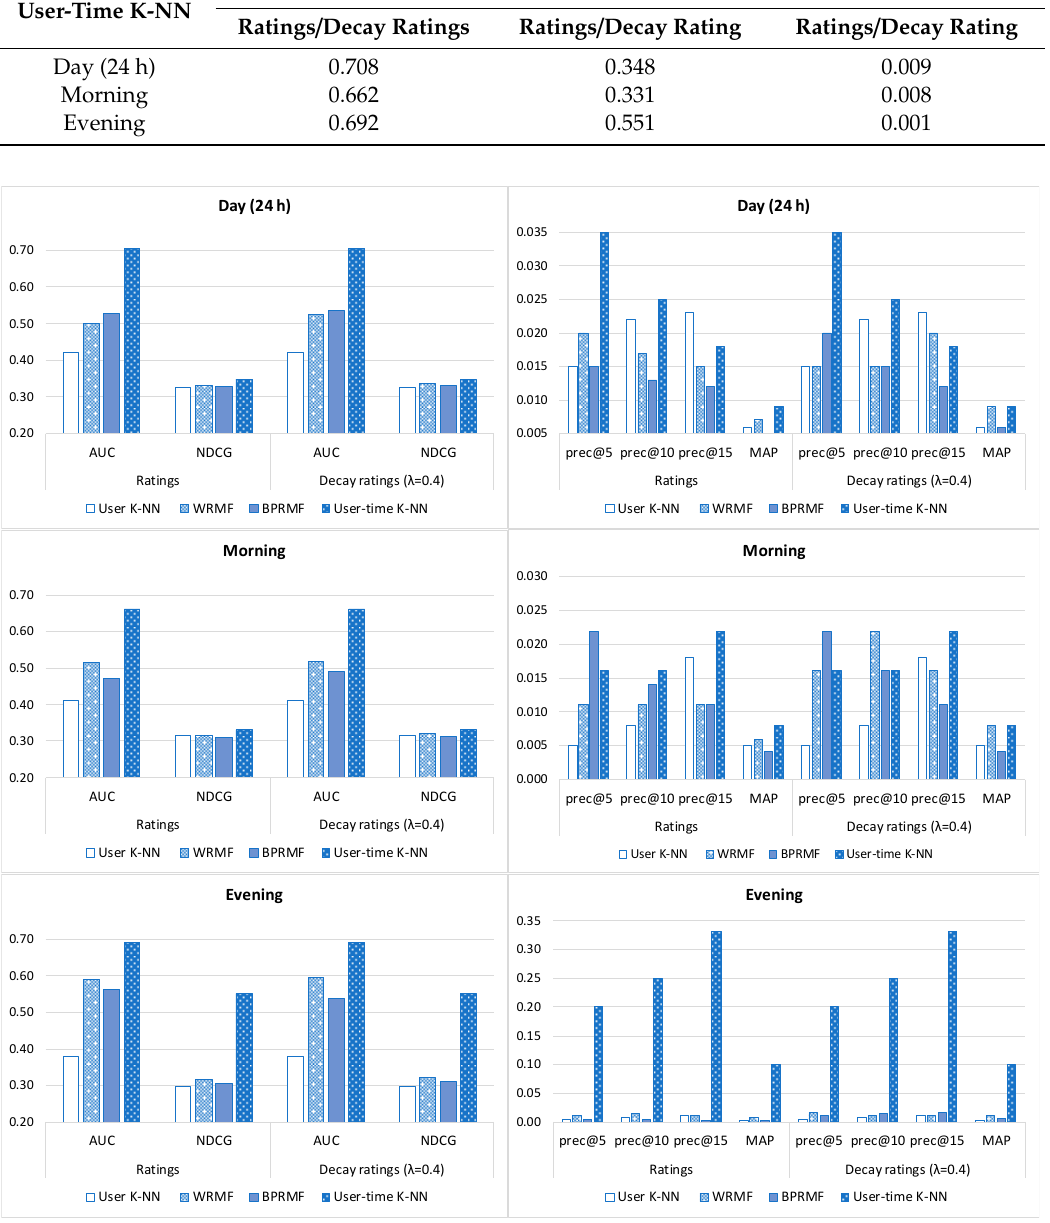
Figure 9. Comparison of the top-N metrics obtained using the proposed user-time K-NN method versus the other recommendation methods for the di ff erent time periods studied. Comparison using ratings and decay